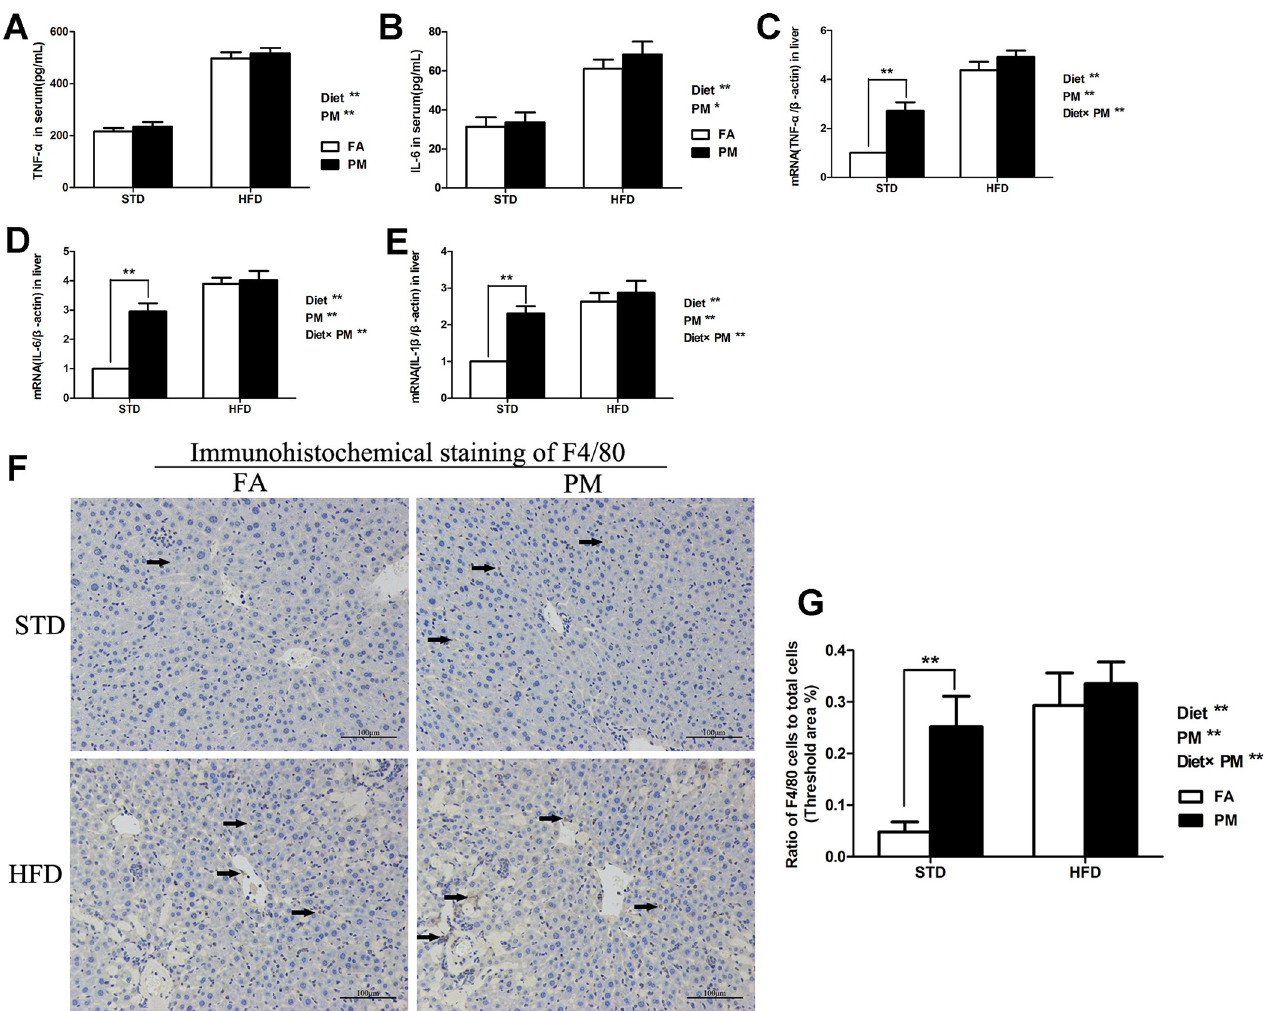
Fig 5. Ambient PM exposure activated inflammatory pathway via regulating JNK in liver. (A) The levels of TNF- α in serum (n = 8). (B) The levels of IL-6 in serum (n = 8). (C) The mRNA expression of TNF- α in liver (n = 5). (D) The mRNA expression of IL-6 in liver (n = 5). (E) The mRNA expression of IL-1 β in liver (n = 5). (F) Immunohistochemical staining of macrophage cell surface marker F4/80 in liver ( × 200, scale bars = 100 μ m). (G) The ratios of activated Kupffer cells (F4/80) to total cells (n = 5). Data are expressed as the mean ± SD. �� , P < 0.01. Diet �� indicates the HFD. PM �� indicates PM exposure. Diet × PM indicates the interaction effect between HFD and PM